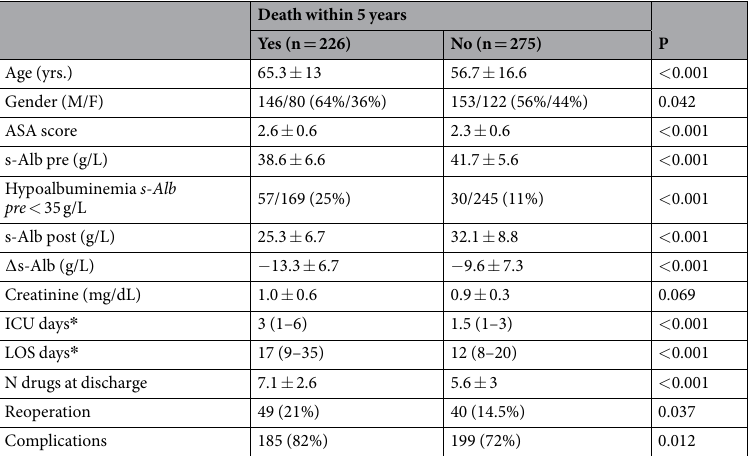
Table 4. Variables associated with of all-cause mortality in 501 complex surgical patients followed for at least five years. * IQR (interquartile